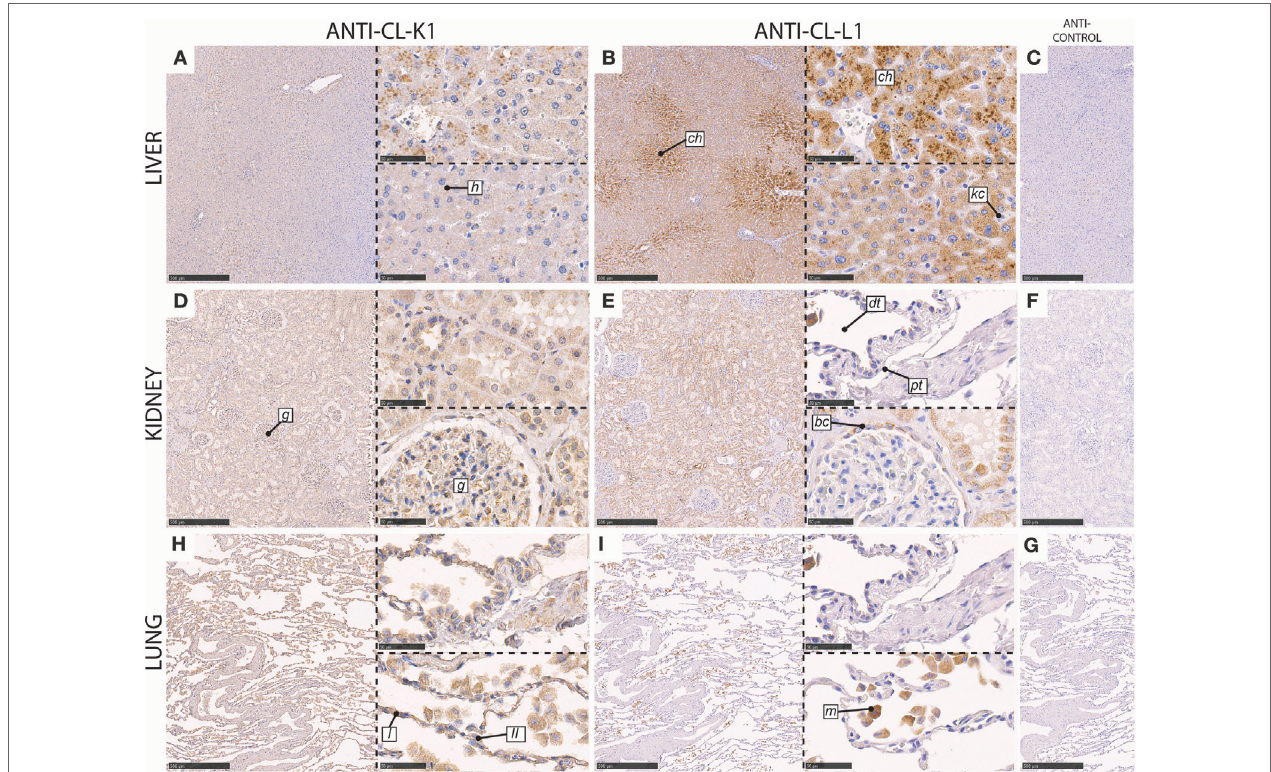
FigUre 3 | Immunohistochemical localization of CL-K1 and CL-L1 in formalin fixed and paraffin embedded sections of the liver (a,B) , kidney (D,e) , and lung (h,i) . Italic letters within images refer to: for the liver h : hepatocytes, ch : centrilobular hepatocytes, and kc : Kupffer cells; kidney g : glomerulus, dt : distal